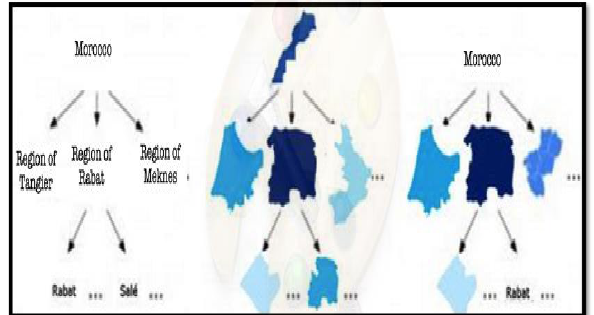
Figure 3: The three modes of representation of spatial dimensions supported by SOLAP represent the administrative subdivision of Morocco (eg country, region,